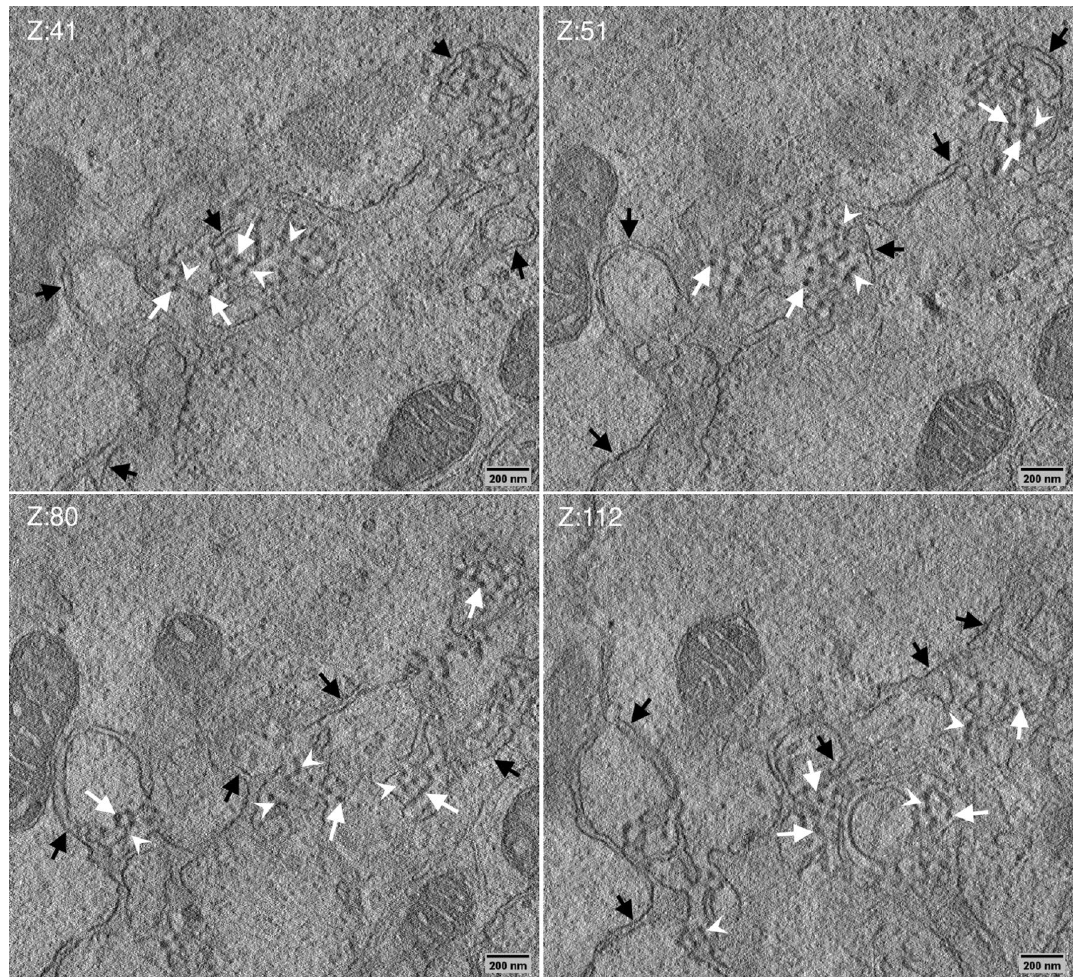
Figure 3. The D13 network structure is intimately associated with the ER. HeLa cells infected without IPTG were prepared as in Fig. 1. Sections, 750 nm in thickness, were subjected to STEM tomography. The figure displays four slices of the reconstructed tomogram slice 41, 51, 80 and 112 (Z:41, Z:51, Z:80 and Z:112). It shows the electron-dense spots (white arrows) displaying a regular pattern. Slice by slice inspection also shows that the spots are connected by thin structures, likely thin membrane tubes (white arrow head; Movie S1). The network structure is associated with, and surrounded by, the ER (black arrows). The slices are taken from